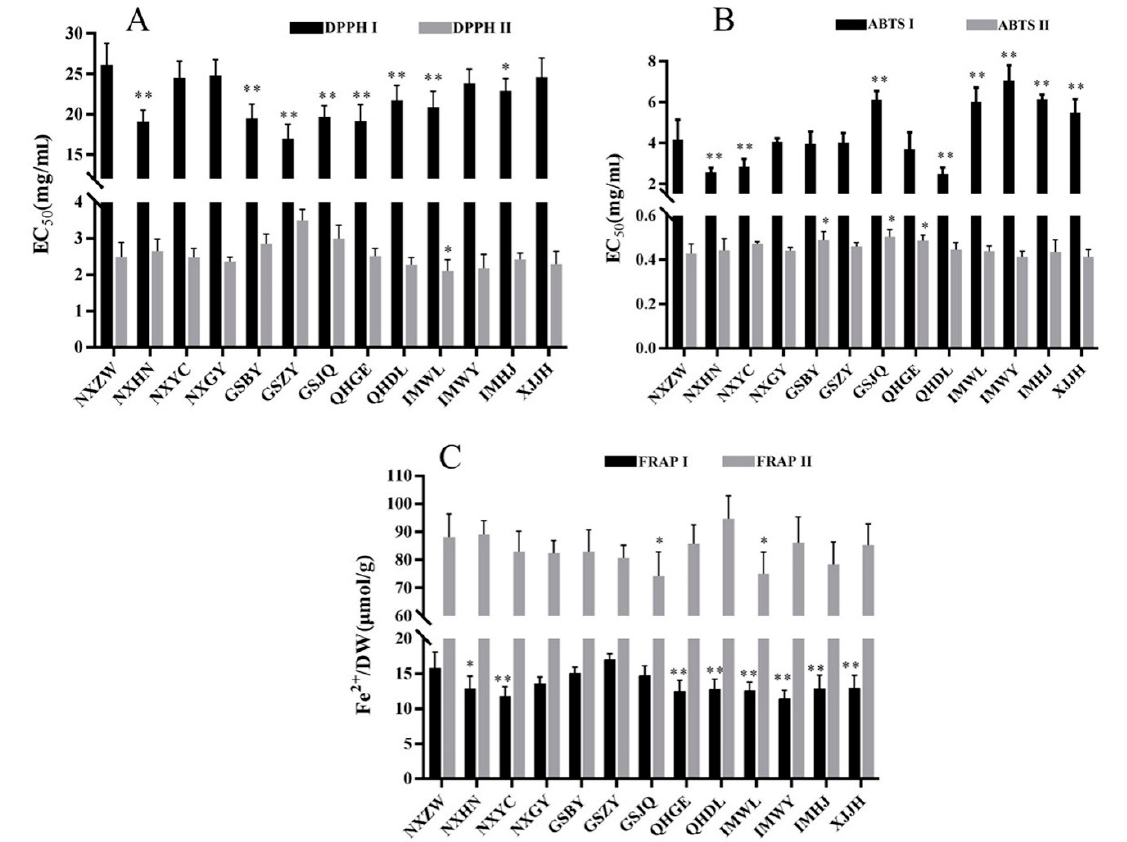
Figure 2. Antioxidant activity for extracts I and II of FLB from different regions 1,2,3,4 ( 1 I, hexane/acetone/ethanol (2:1:1, v / v / v ) extraction; II, 80% ethanol solution extraction; 2 ( A ) EC 50 of DPPH; ( B ) EC 50 of ABTS; ( C ) concentrations of Fe 2+ /DW; 3 * and ** represent significant differences with the Daodi herb region (NXZW), p < 0.05 and p < 0.01, respectively; 4 NXZW, Zhongwei of Ningxia; NXHN, Huinong of Ningxia; NXYC, Yinchuan of Ningxia; NXGY, Guyuan of Ningxia; GSBY, Baiyin of Gansu; GSZY, Zhangye of Gansu; GSJQ, Jiuquan of Gansu; QHGE, Ge’ermu of Qinghai; QHDL, Delingha of Qinghai; IMWL, Urad Front Banner of Inner Mongolia; IMWY, Wuyuan of Inner Mongolia; IMHJ, Hanggin Rear Banner of Inner Mongolia; XJJH, Jinghe of Xinjiang.